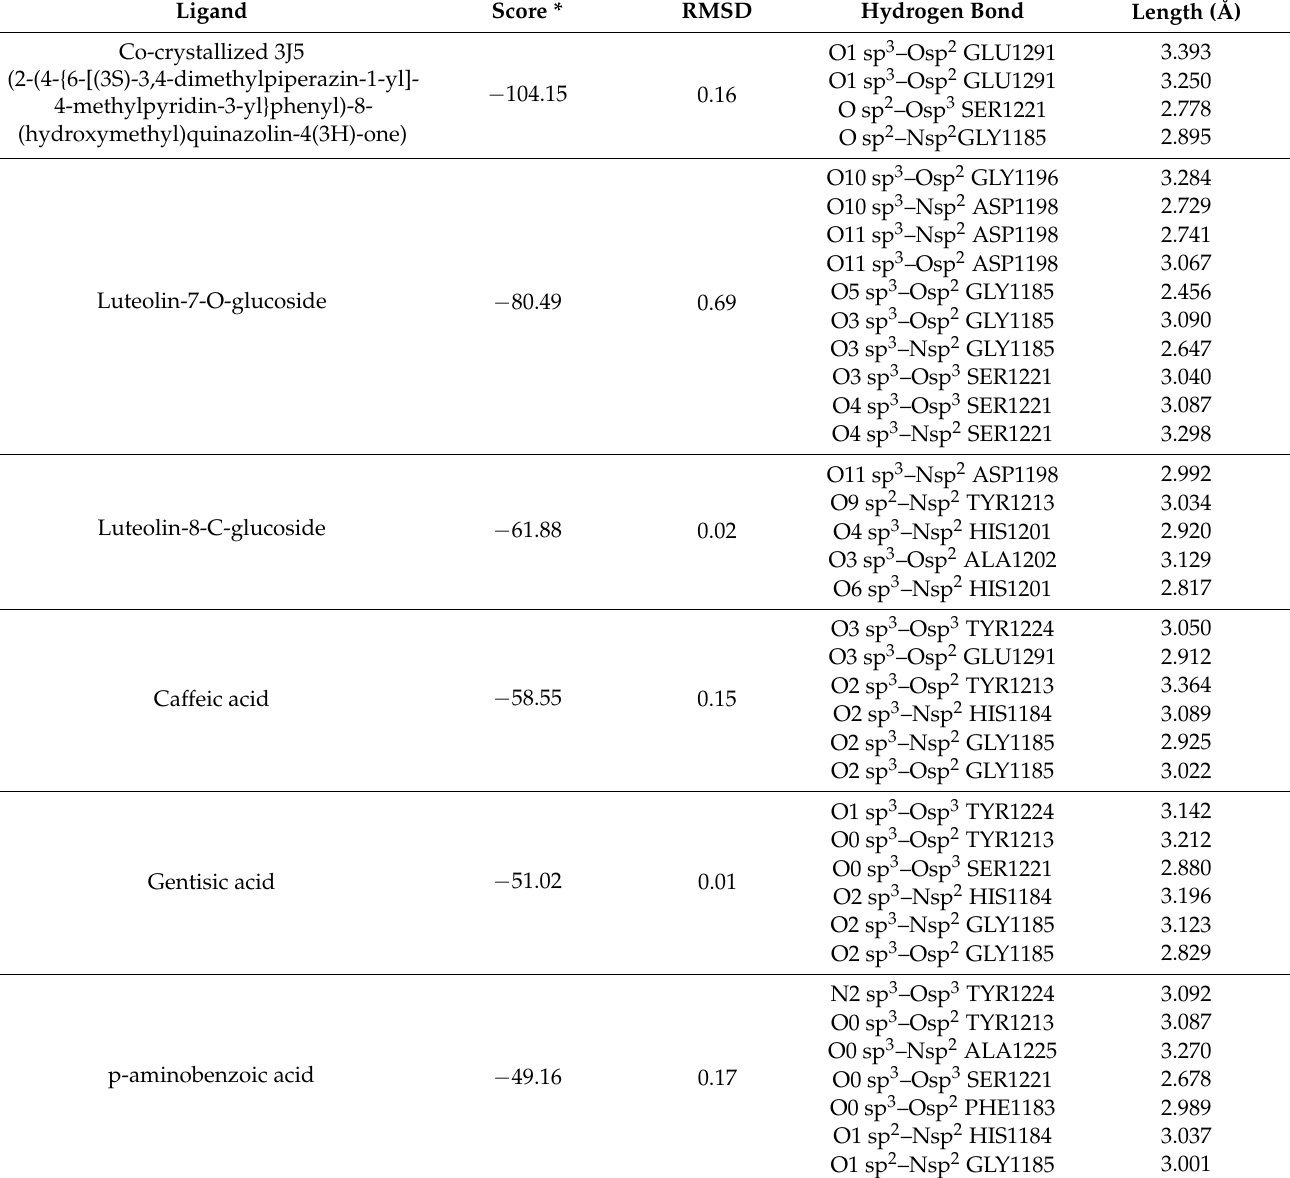
Table 1. Results of molecular docking study on human tankyrase 1 (PDB ID: 4W6E, chain A)